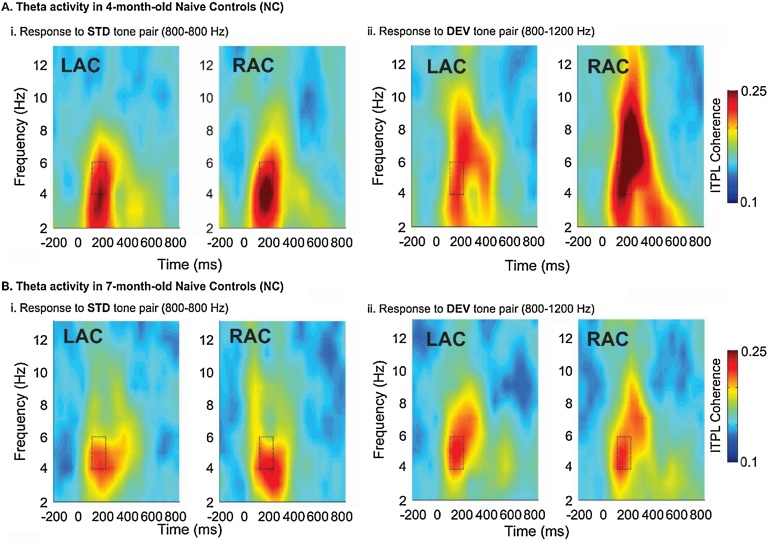
Inter-trial Phase Locking (ITPL) in 4- and 7-month-old infants to invariant standard (STD) and variant deviant (DEV) tone pairs in the Left (LAC) and Right (RAC) auditory cortices. Dashed-line boxes show significant time-frequency clusters. A) At 4-months-of- age, ITPL shows a low-frequency burst subsequent to first tone onset (time 0), to Standard (STD, Ai) and Deviant (DEV, Aii) tone pairs. Frequency change in the DEV condition (Aii) elicits a greater phase coherence in the RAC, compared to the LAC and the STD response. B) At 7 months this burst of phase-locked energy decreases and the rightward asymmetry in the DEV response (Bii) is lessened.